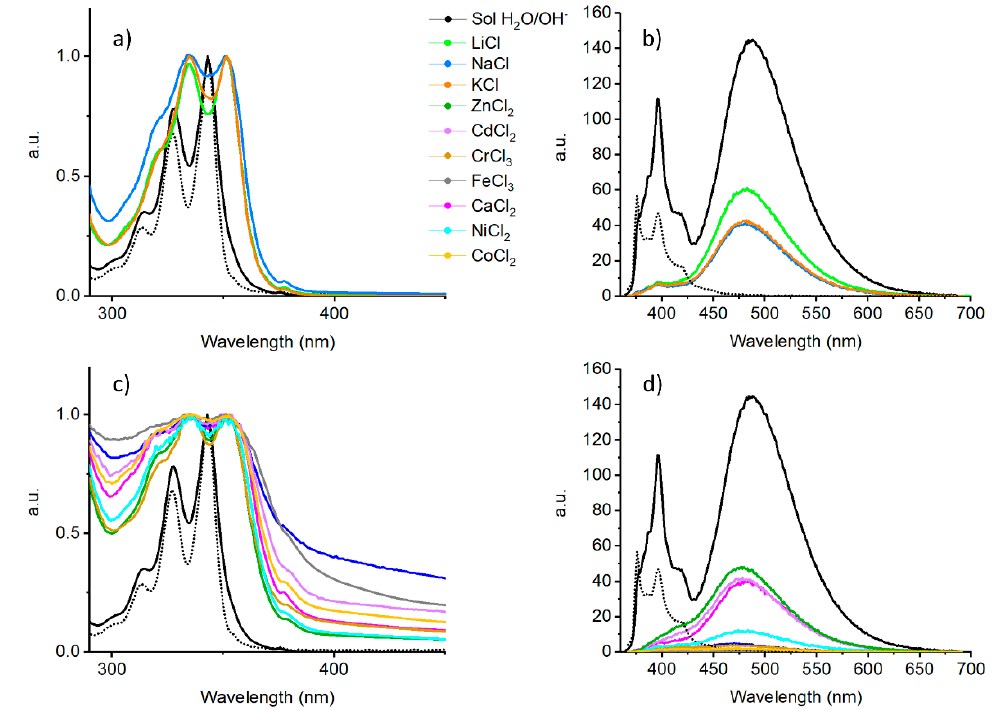
Figure 3. ( a ) Normalized UV-Vis absorption and ( b ) non-normalized emission spectra ( λ exc = 352 nm) of the monovalent cation triggered gels; ( c ) Normalized UV-Vis absorption and ( d ) non-normalized emission spectra ( λ exc = 352 nm) of the divalent and trivalent cation triggered gels. The data of the aqueous solutions of 1 at 0.5% (solid black line) and 0.005% concentration (black dotted line) have been included for comparison.